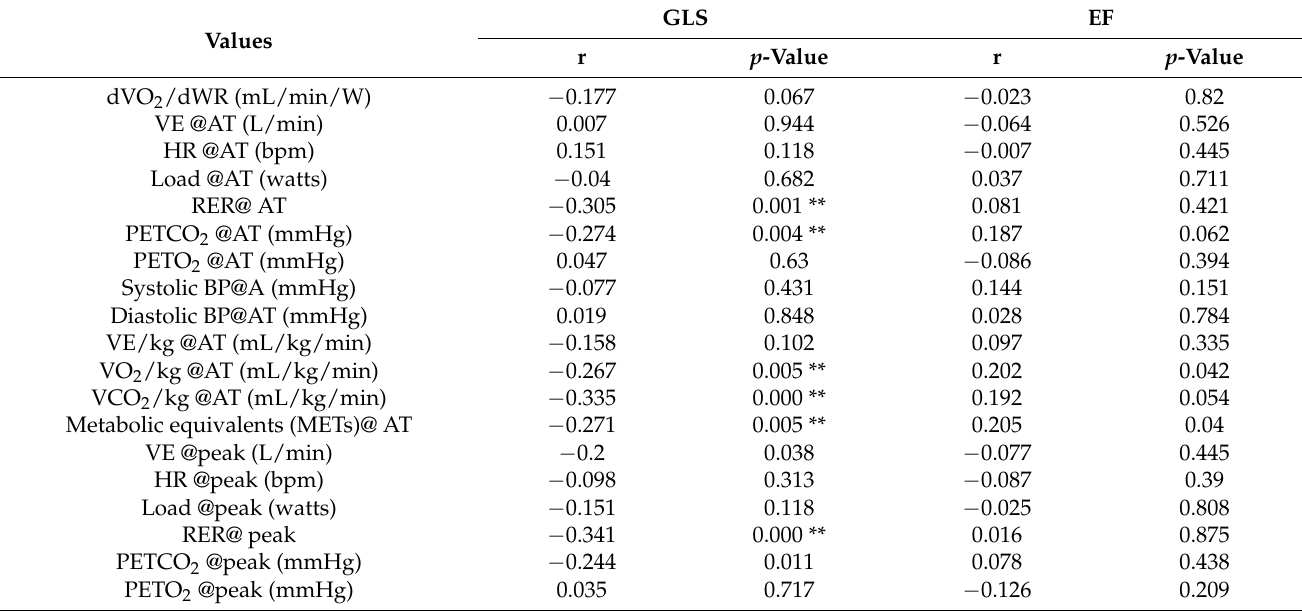
Table 3. Correlations between numerical parameters of CPX with the left ventricular ejection fraction (LVEF) and global longitudinal strain